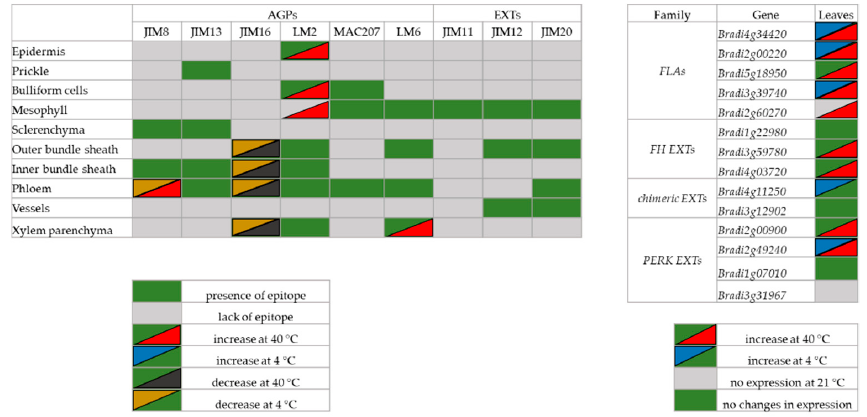
Figure 9. Consolidated results of the distribution of the epitopes EXT and AGP in the leaves of B. distachyon and changes in the level of transcript accumulation of the analysed genes.